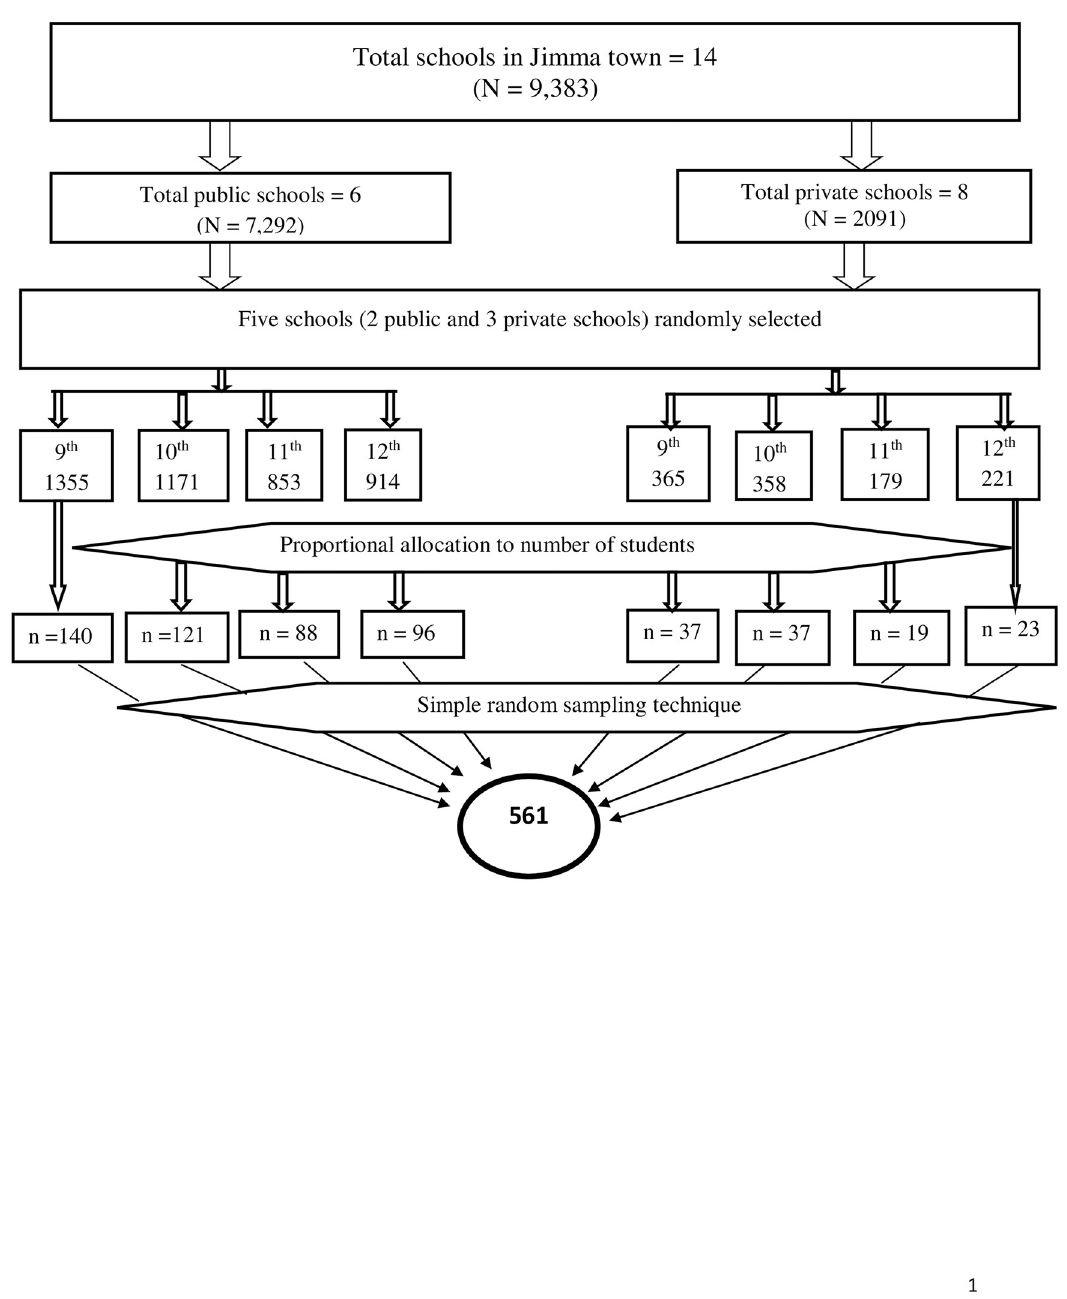
Fig 1. Schematic representation used in the selection of school-going adolescent in Jimma town, Southwest Ethiopia (n = 546).